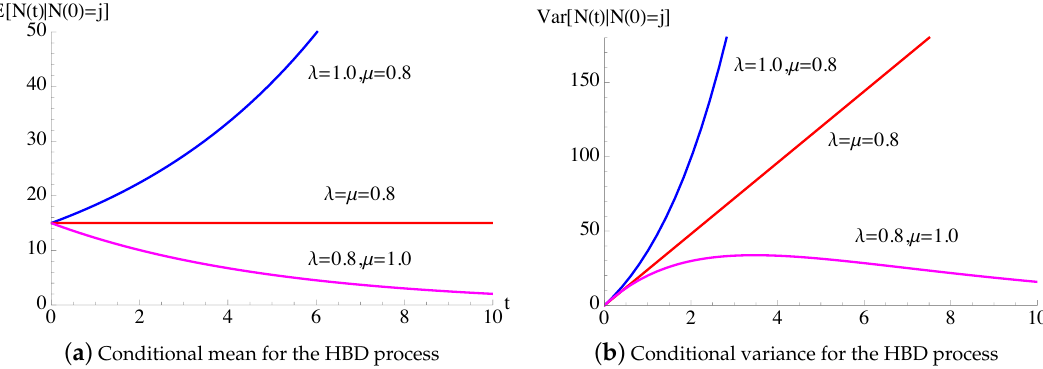
Figure 4. For the time-homogeneous linear birth–death ( HBD ) process, the conditional mean and the conditional variance (35) are plotted as function of t , with j = 15, for some choices of λ and µ